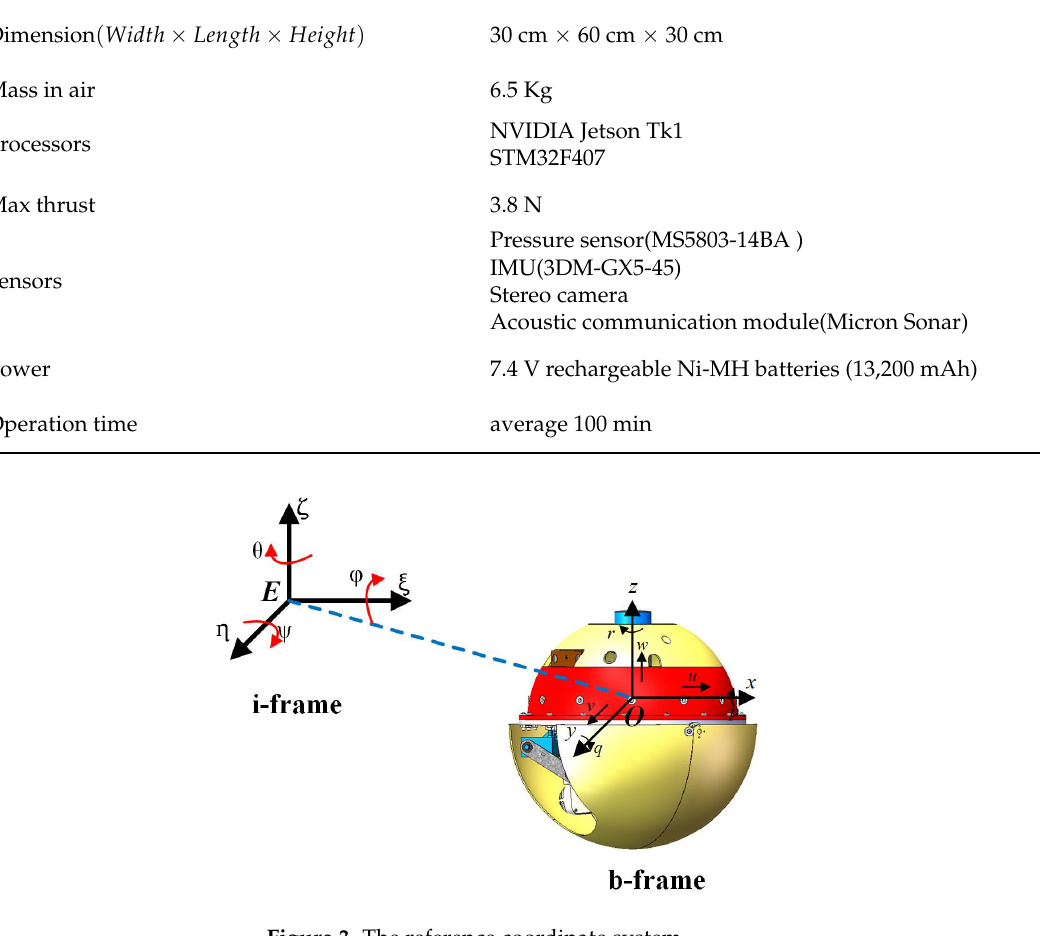
Figure 3. The reference coordinate